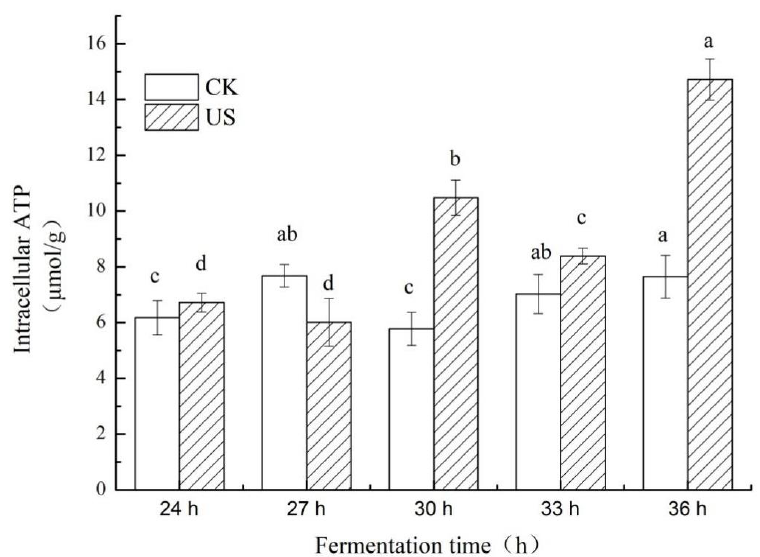
Figure 5. Comparison of ATP concentration during ultrasound-assisted fermentation by SAR 14-116. (Lowercase letters a, b, c and d indicate that there is a significant difference between the different culture times of fermentation ( p < 0.05)).